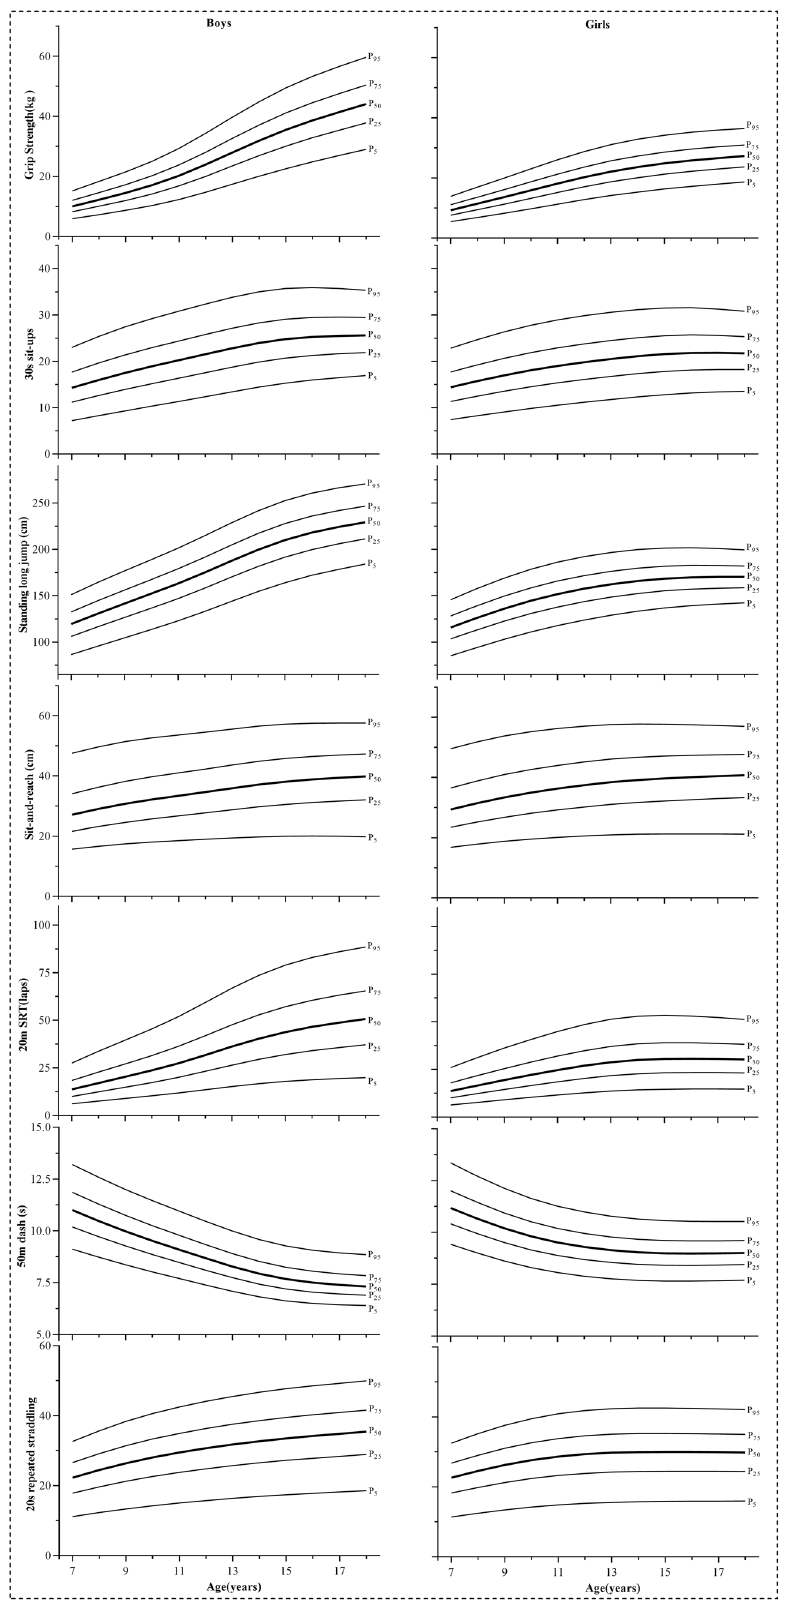
Figure 1. Smoothed centile curves of seven physical fitness tests for Chinese children and